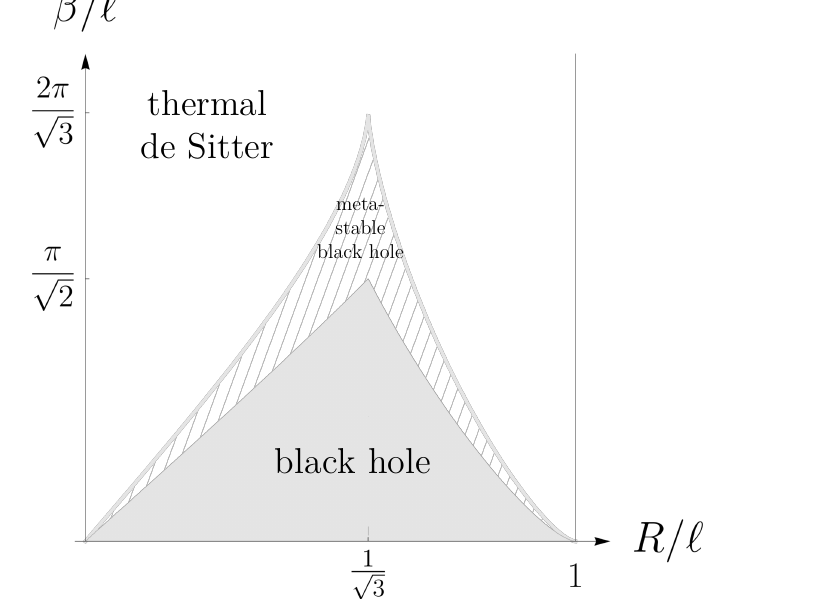
Figure 8. Phase diagram for thermal dS and b-horizon configurations, with boundary size R and inverse temperature β .